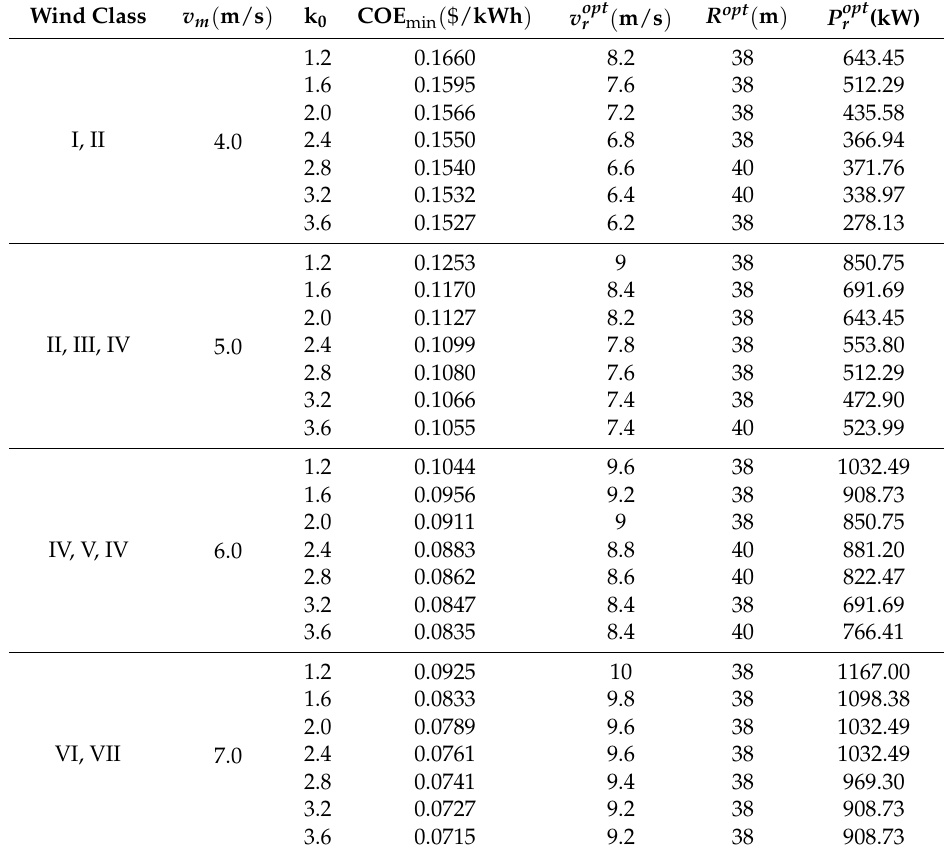
Table 6. Minimal COEs and optimal design parameters at different wind classes and wind